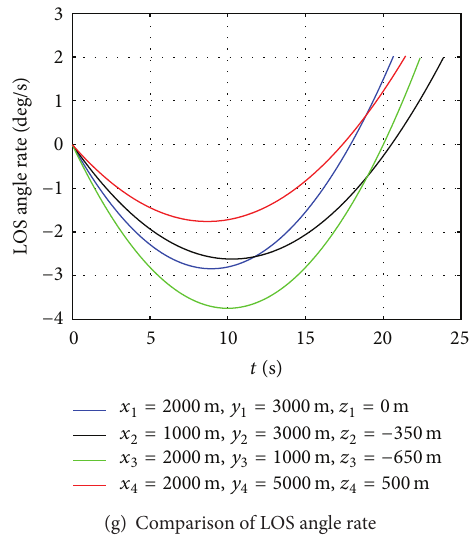
Figure 22: Comparison of BPN in different initial